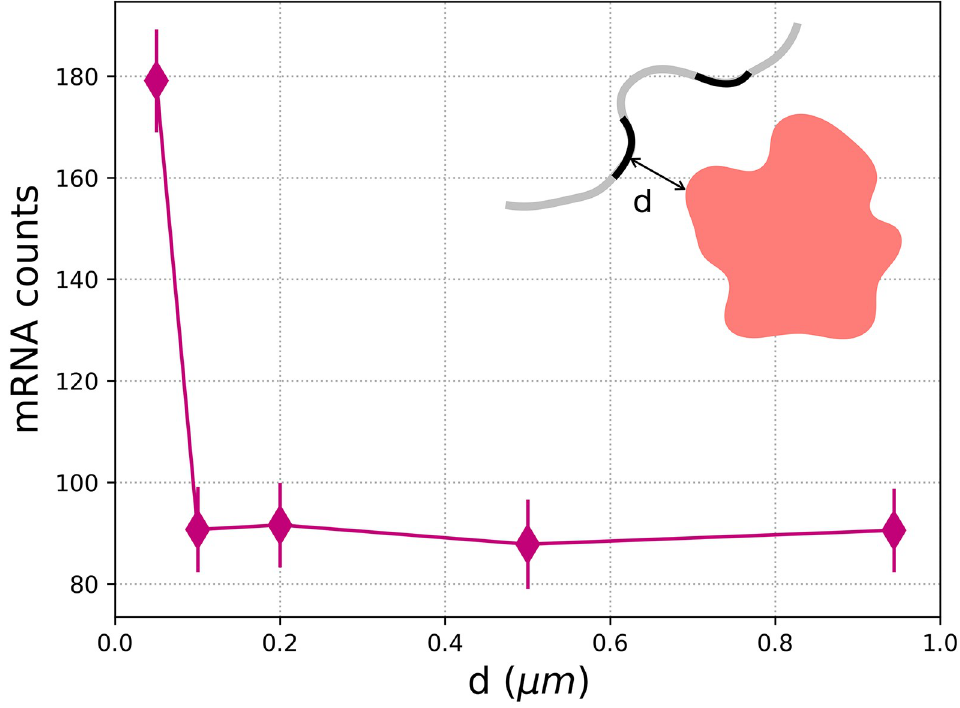
Fig 6. Our model predicts that the mRNA production decreases by a factor of two, above 0.05 μ m. An schematics shows a nuclear speckle in red and the distance of active genes on chromatin (curved line in grey) from the speckle periphery (d). Error bars represent the standard deviations. For each condition, 20 simulation replicates were performed.